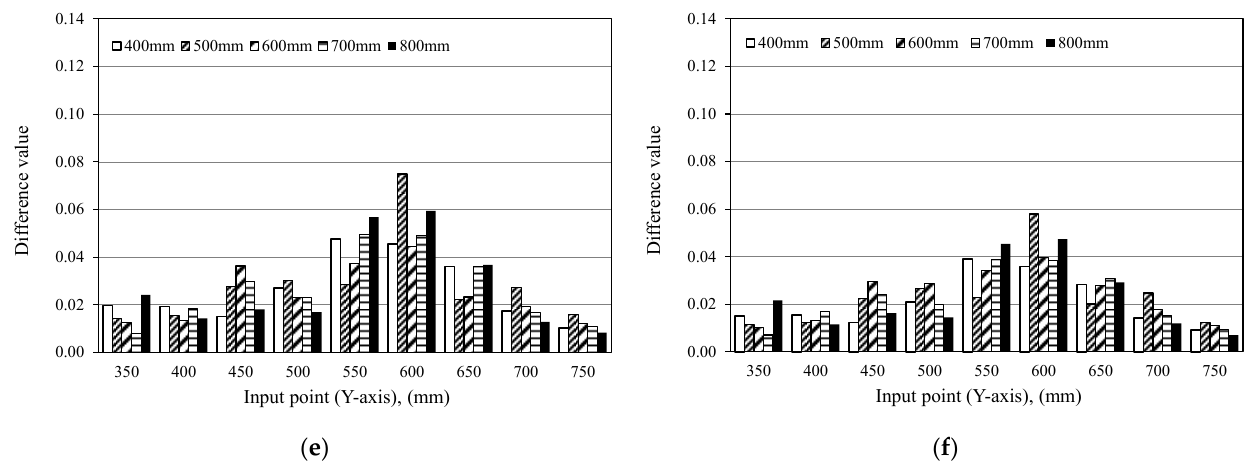
Figure 13. DVA results for Case_1 ( φ S : 63 mm, Depth: 50 mm): ( a ) N = 100; ( b ) N = 250; ( c ) N = 500; ( d ) N = 1000; ( e ) N = 1500; ( f ) N = 2000.